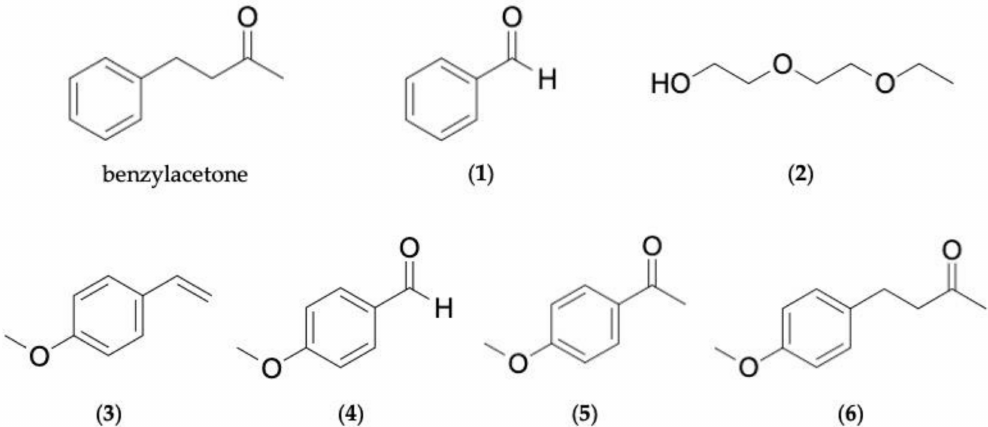
Figure 1. Chemical structures of compounds investigated for sedative effects in the study: benzylacetone (positive control); benzaldehyde ( 1 ); diethylene glycol monoethyl ether (DEGEE) ( 2 ); p -vinylanisole ( 3 ); p -anisaldehyde ( 4 ); acetanisole ( 5 ); and anisylacetone ( 6 ). All seven compounds were found in aroma of K1. Only benzylacetone, compounds 1 , 2 , and 4 were present in aroma of K2. (Compounds are numbered in order of elution from DB-WAX